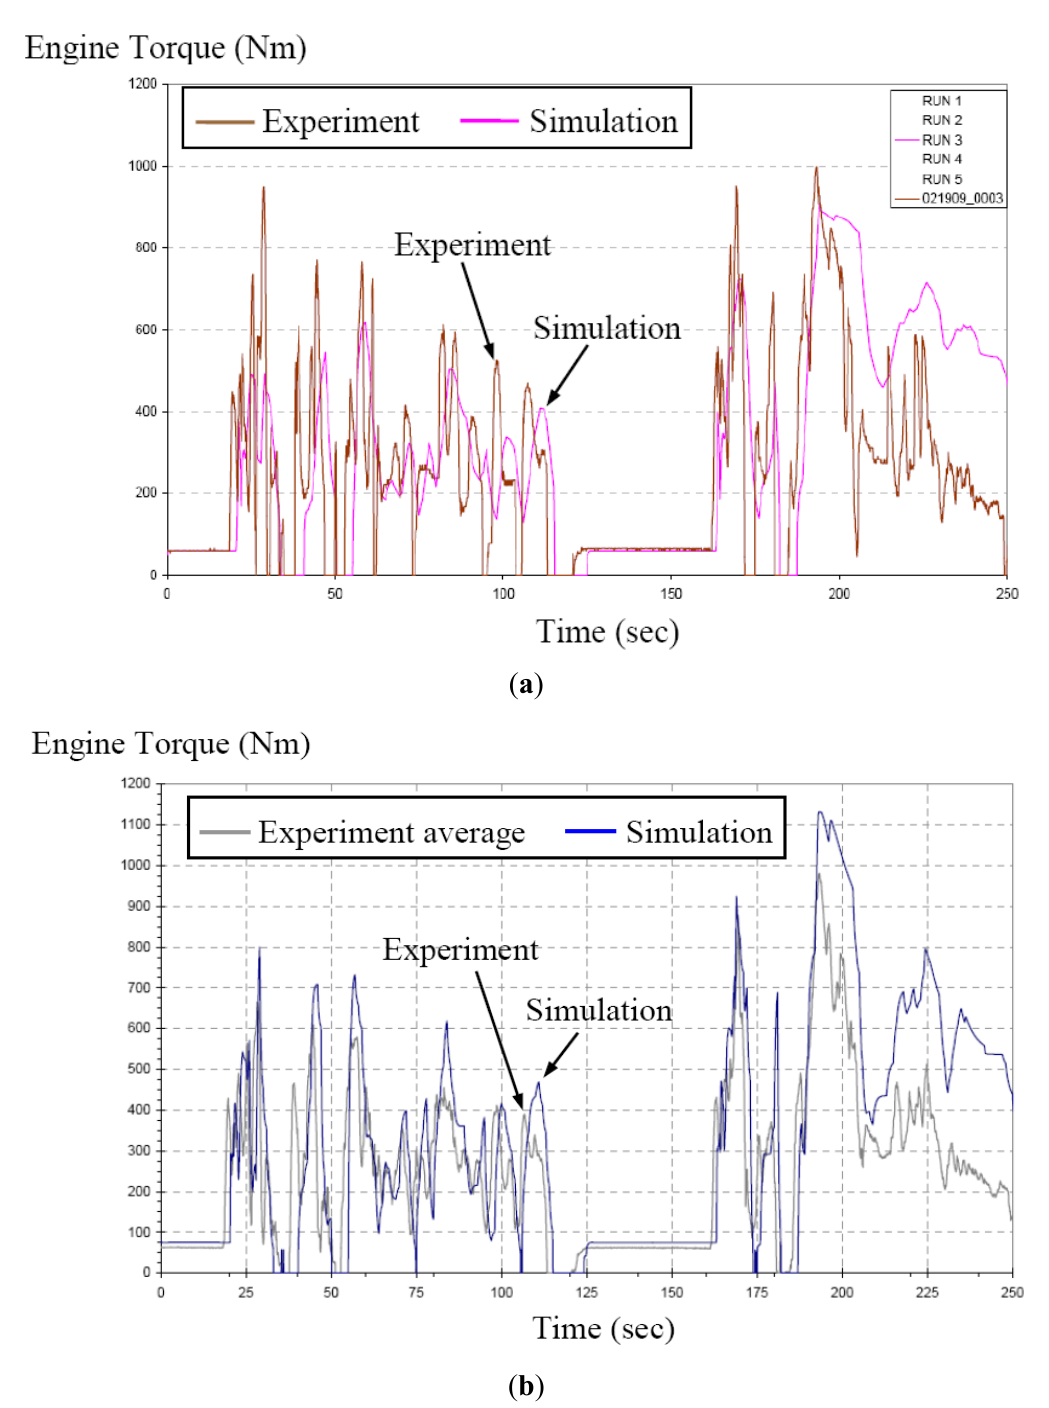
Figure 6. Comparison of simulated engine torque and vehicle speed with experimental data—baseline. ( a ) Engine torque plot with PID (10-0.1-0) control; ( b ) Engine torque